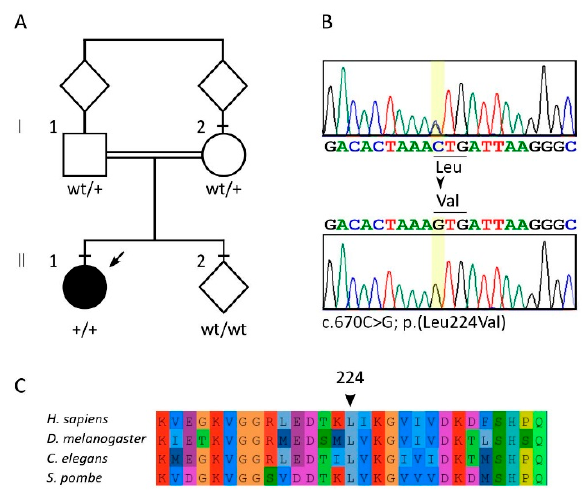
Figure 1. Pedigree ( A ) and genetic analyses ( B ). Whole exome sequencing identified a homozygous missense variant in exon 5 of CCT5 c.670C>G p.(Leu224Val) (NM_012073). Leucine 224 is evolutionarily conserved from yeasts to vertebrates ( C ), each color corresponds to a single specific amino acid.